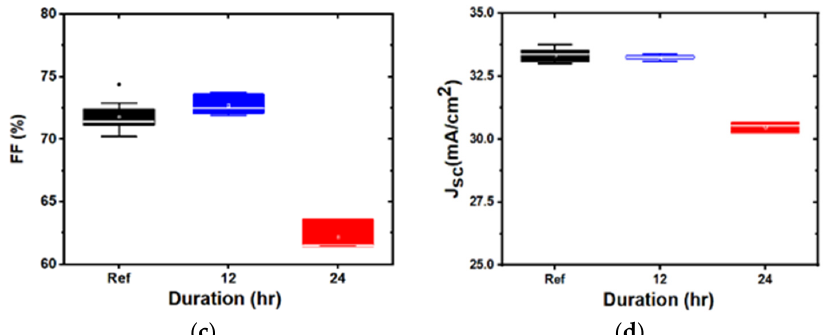
Figure 5. Box plots of device parameters for indium tin oxide (ITO) deposited at 5 mTorr, soaked for different durations: ( a ): efficiency; ( b ): open circuit voltage; ( c ): fill factor; and ( d ): short circuit current density.